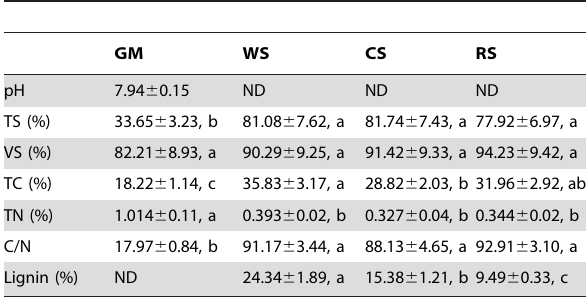
Table 1. Chemical characterization of substrates used in the co-digestion